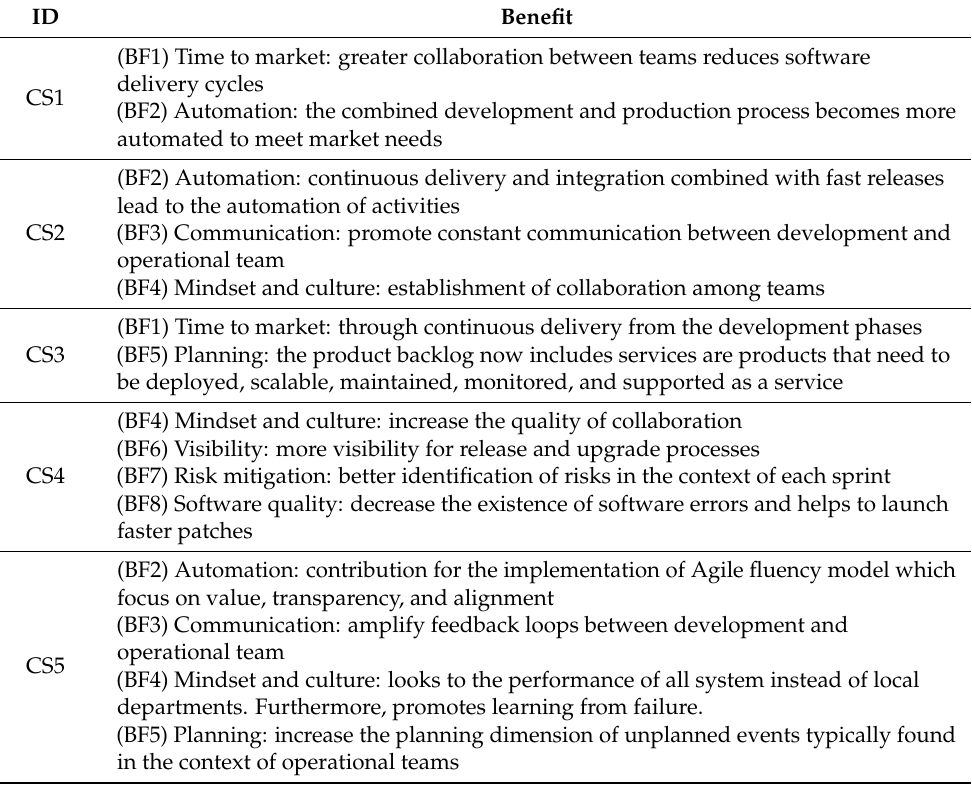
Table 3. Identified benefits themes in the case studies.